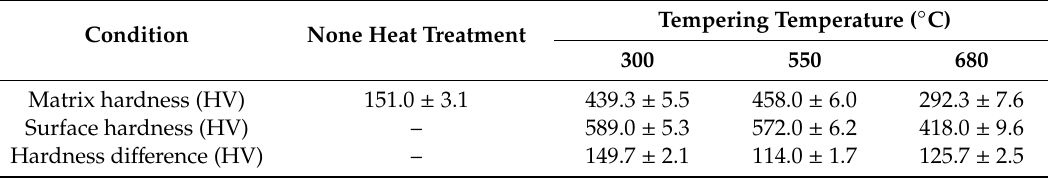
Table 2. Micro-hardness of surface layer and matrix after wear tests.